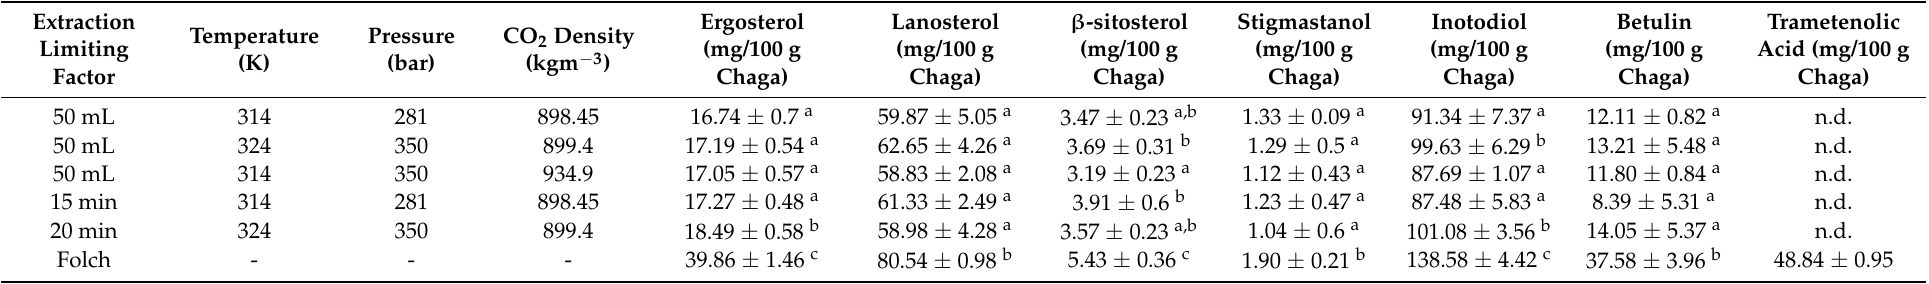
Table 3. The amount of the identified triterpenoids extracted from Chaga with SC-CO 2 and Folch method, expressed as mg/100 g dry weight of Chaga. Data are expressed as mean ± standard deviation. The different letters (a–c) indicate significant difference ( p < 0.05). ( n = 9, 3 extraction replicates and 3 analytical replicates).